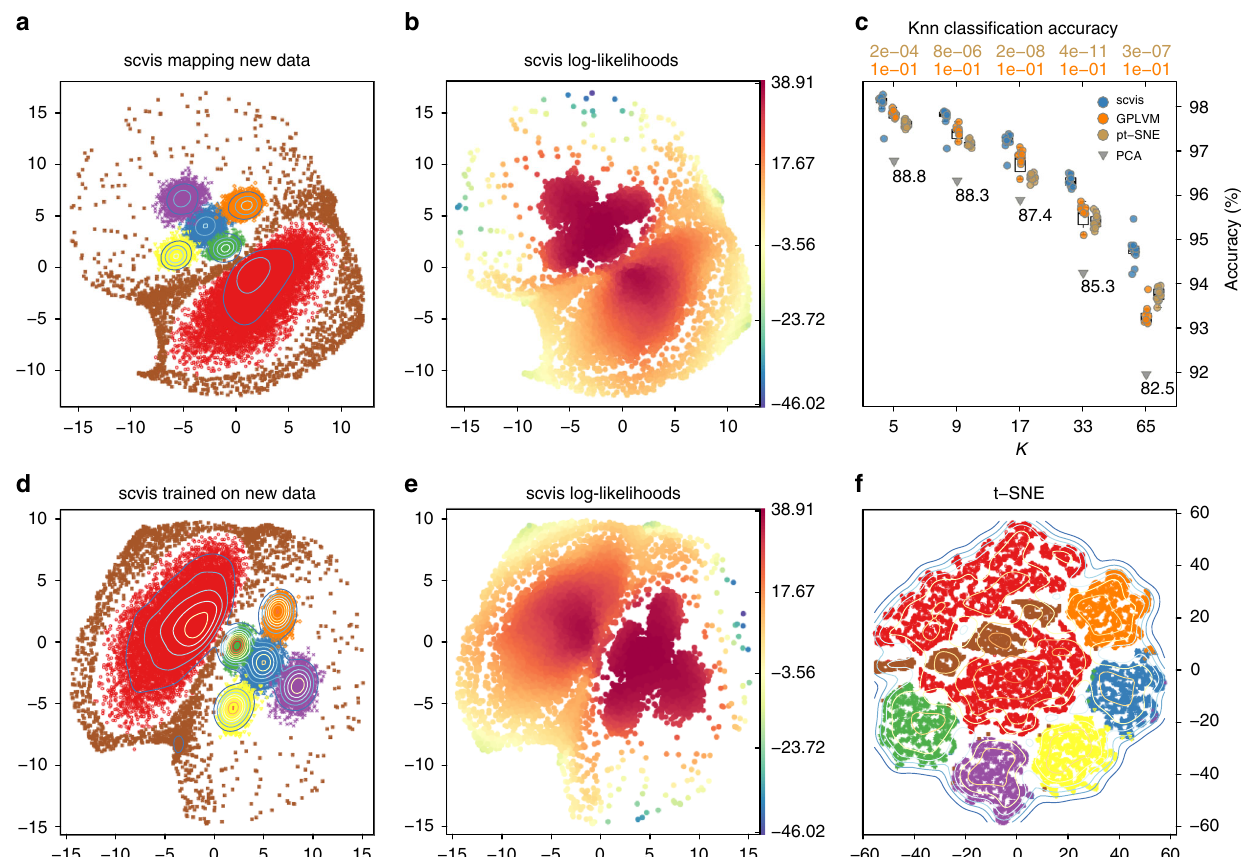
Fig. 3 Benchmarking scvis against GPLVM, parametric t-SNE, and PCA to embed 22,000 synthetic out-of-sample data. a scvis mapping 22,000 new data points based on the learned probabilistic mapping function from the 2200 training data points, b the estimated log-likelihoods, and c the average K -nearest neighbor classi fi cation accuracies for different K s across 11 runs, the classi fi ers were trained on the 11 embeddings from the 2200 points. The numbers at the top are the FDR (one-sided Mann – Whitney U -test) comparing the K -nearest neighbor classi fi cation accuracy from scvis with those from GPLVM (orange, bottom) and those from parametric t-SNE (golden, top). Notice that, for GPLVM, two runs produced bad results and were not plotted in the fi gure. Boxplots denote the medians and the interquartile ranges (IQR). The whiskers of a boxplot are the lowest datum still within 1.5 IQR of the lower quartile and the highest datum still within 1.5 IQR of the upper quartile. d scvis results on the larger dataset with the same perplexity parameter as used in Fig. 2; e scvis log-likelihoods on the larger dataset; and f t-SNE results on the larger